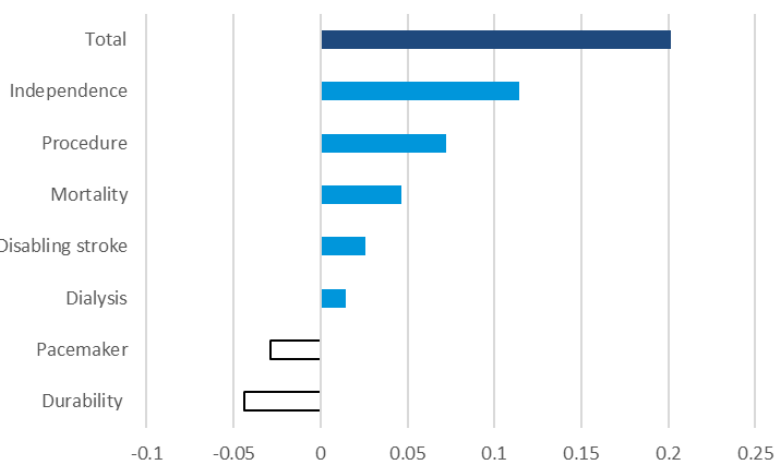
Figure 2. Incremental value of transcatheter aortic valve replacement vs. surgical aortic valve replacement in patients ≥ 60 years old.